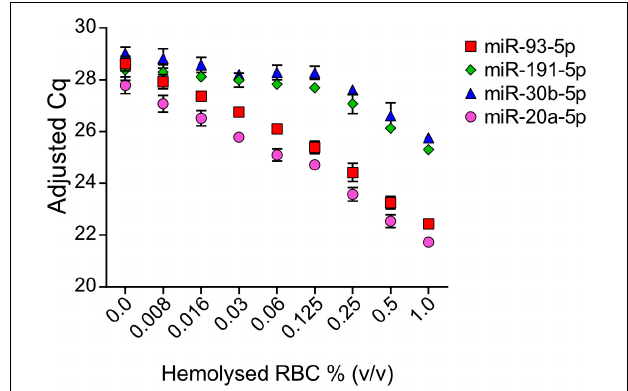
the RQs of both miR-371a-3p and miR-372-3p were statistically significant lower in the samples with added RBCs than in the sample with no added RBCs when miR-93-5p was used as